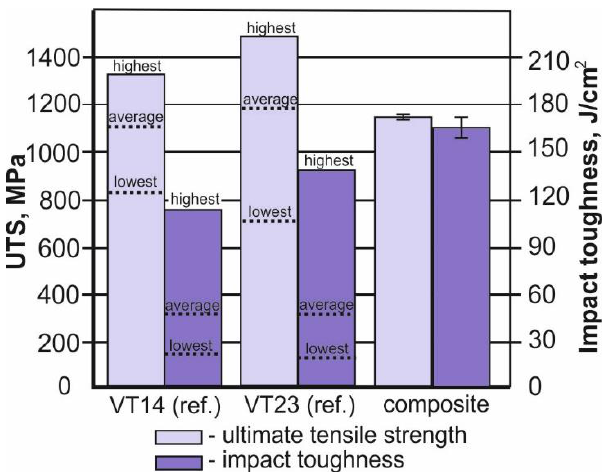
Figure 9. Results of tensile and impact bending tests of the explosively welded composite and properties of bulk VT23 and VT14 titanium alloys. The highest, the lowest, and the average values of properties of the bulk materials are calculated based on the data of Il ′ in et al. [7].